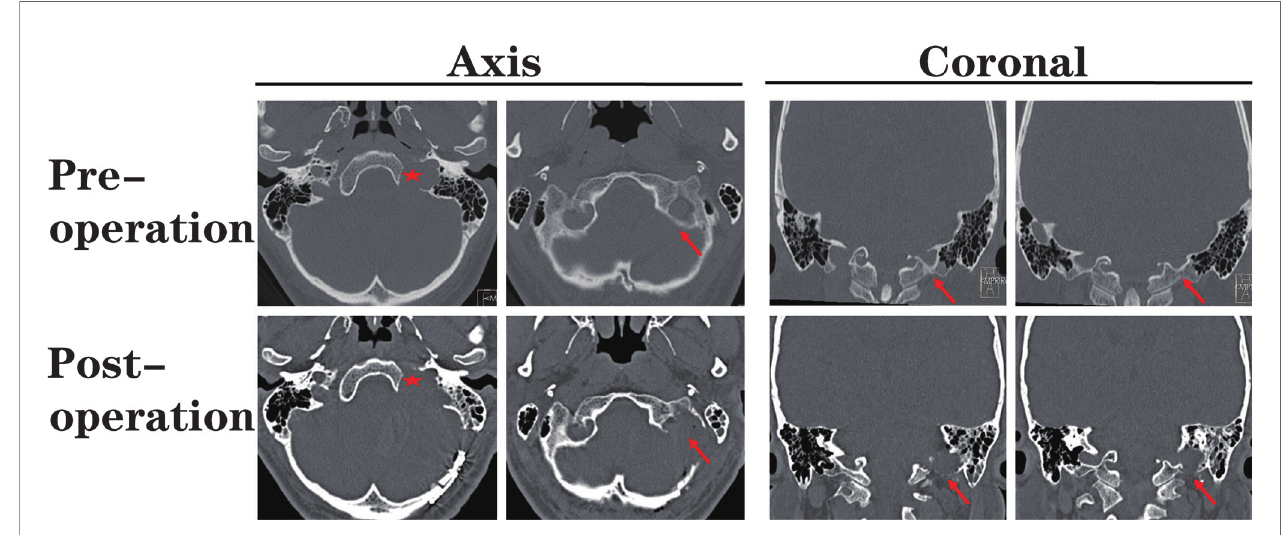
FIGURE 3 | The pre- and post-operational high-resolution computed tomography (HRCT) indicated the extent of paracondylar bone removal. During the suboccipital paracondylar-lateral cervical approach, the jugular process was precisely removed while the condyle was kept intact. Red star: enlarged jugular foramen; Red arrow: the extent of removed bone mass.